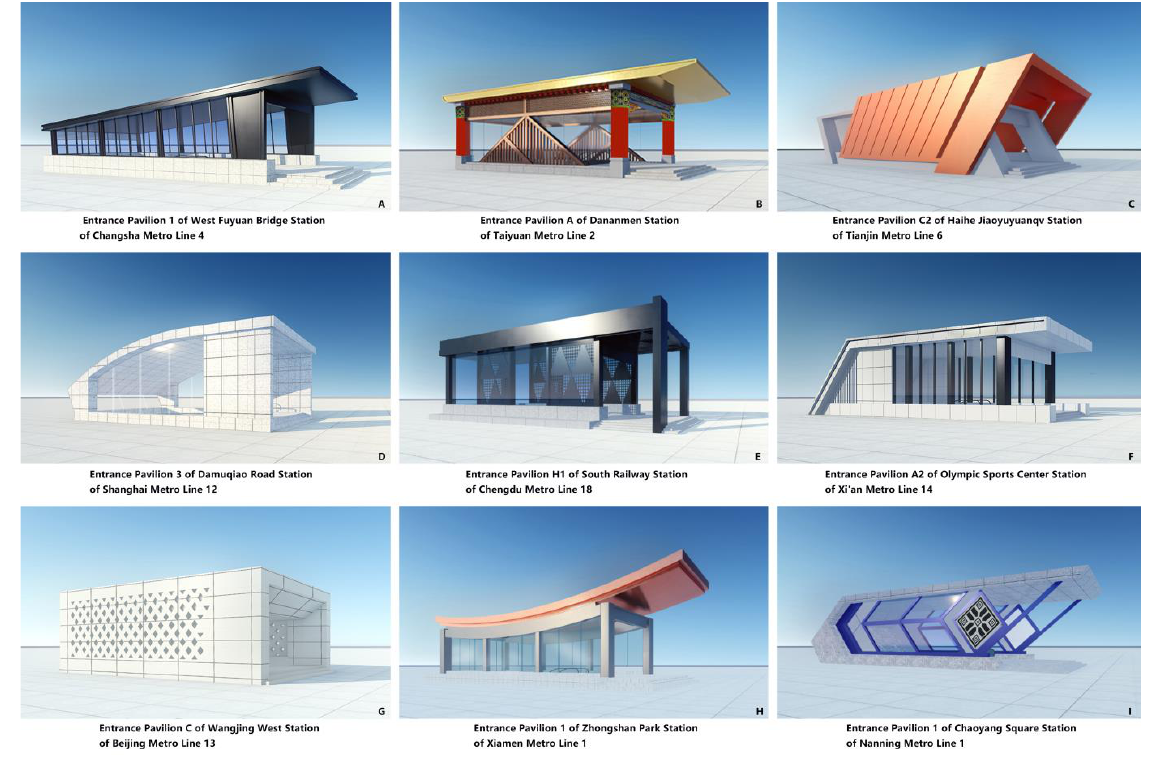
Figure 4. Nine renderings.